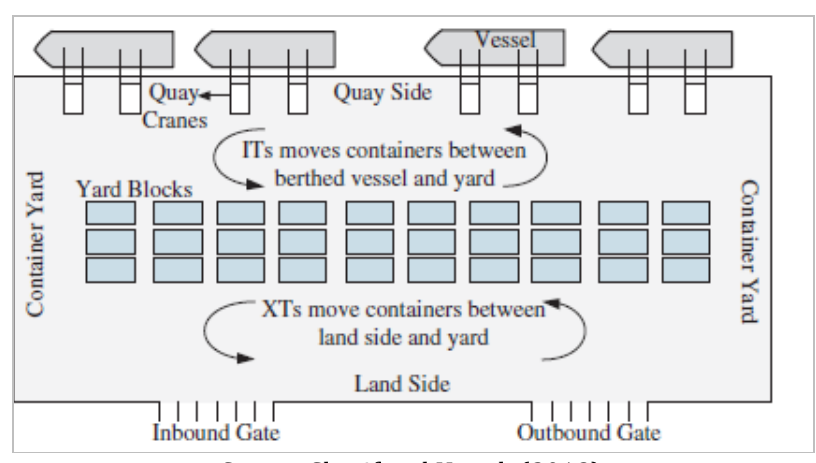
Figure 1: A schematic diagram of container terminal